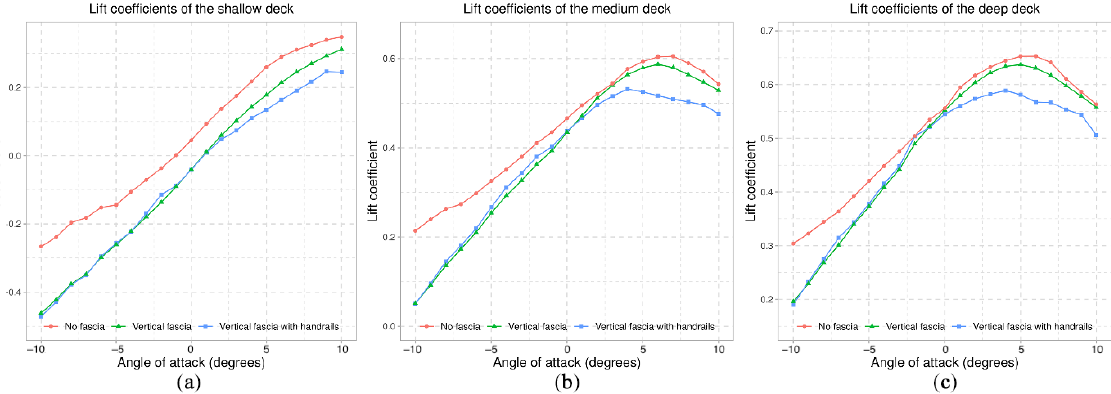
Figure 29. Change in lift coefficients with the inclusion of vertical fascia beams and handrails for the ( a ) shallow deck, ( b ) medium deck, and ( c ) deep deck.